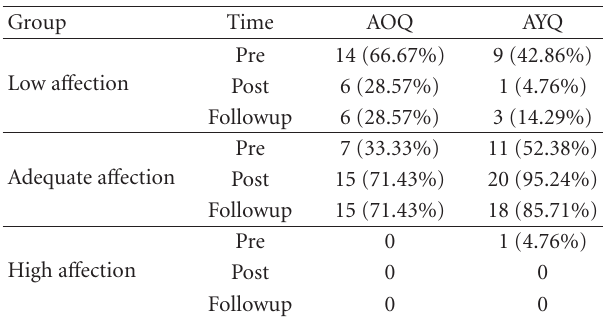
Table 3: Number and percentage (parentheses) of participants in the low-a ff ection, adequate a ff ection, and high-a ff ection groups at pre-, post-, and